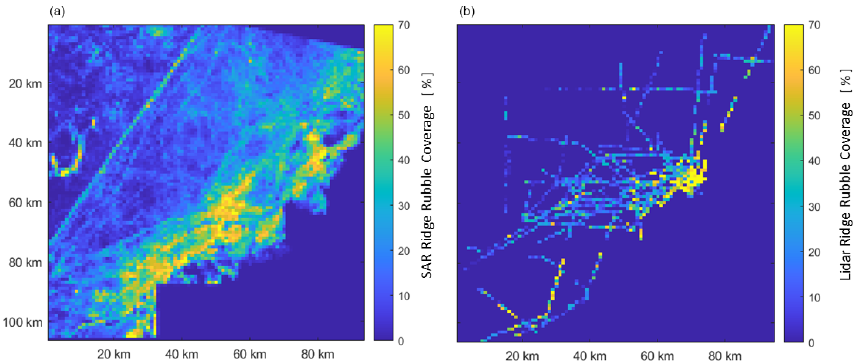
Figure 12. The analysis image over the test area presented as a SAR RRC image (a) and the corresponding lidar RRC image (b) . The units are percentage points in both images.